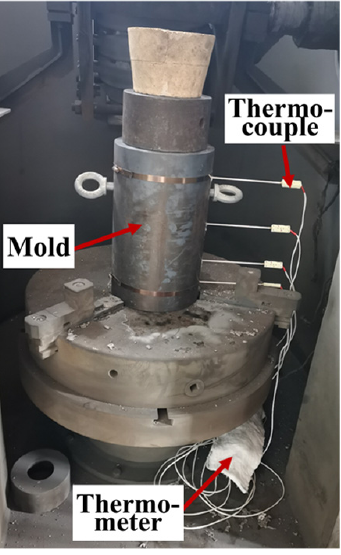
Figure 2. Experimental set-up of experimental casting mold and temperature measurement system.